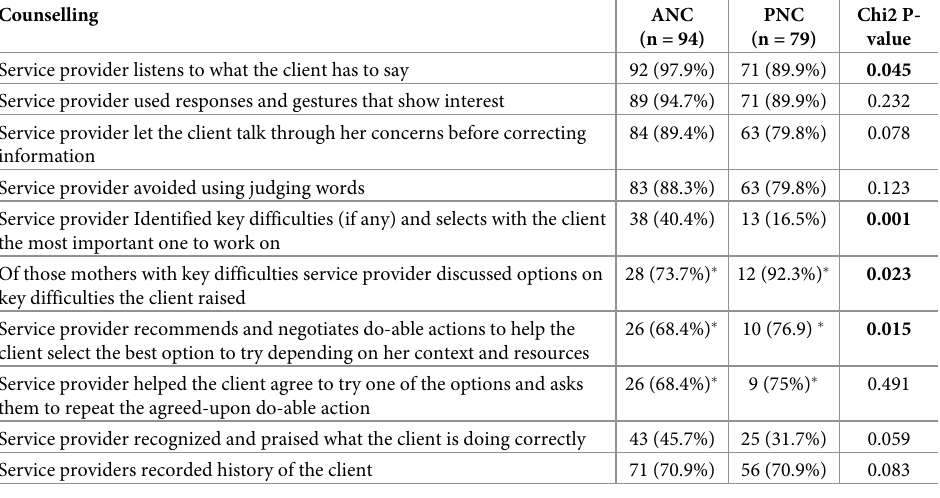
Table 10. Counselling skill of service providers during provision of counseling at ANC and PNC service points.